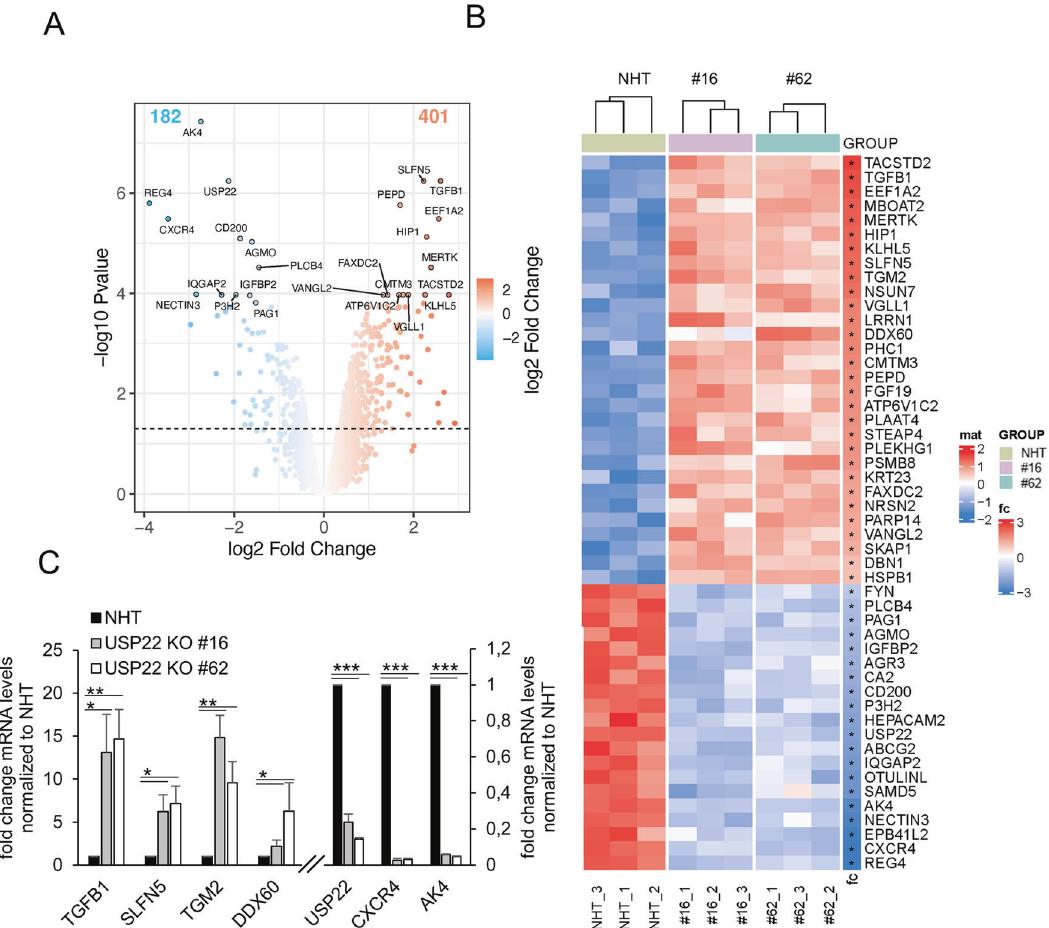
Fig. 1 Pro fi ling USP22-mediated gene expression in HT-29 hIECs. A . Volcano plot showing the differential gene expression patterns of two independent single-cell HT-29 USP22 CRISPR/Cas9 KO clones (#16 and #62) compared to CRISPR/Cas9 control (NHT) HT-29 cells. Color code represents the log2 fold change compared to NHT. B Heatmap of the top-50 differentially regulated genes between HT-29 USP22 KO single clones #16 and #62 and the NHT control. Color coding represents the row-wise scaled (Z-score) RNA intensities. Genes are sorted according to their log2 fold change, compared to NHT. C Basal mRNA expression levels of the indicated genes were determined in control and two independent USP22 KO HT-29 single clones using qRT-PCR. Gene expression was normalized against 28S mRNA and is presented as x-fold mRNA expression compared to NHT. Mean and SD of three independent experiments in triplicate are shown. * P < 0.05; ** P < 0.01, *** P <